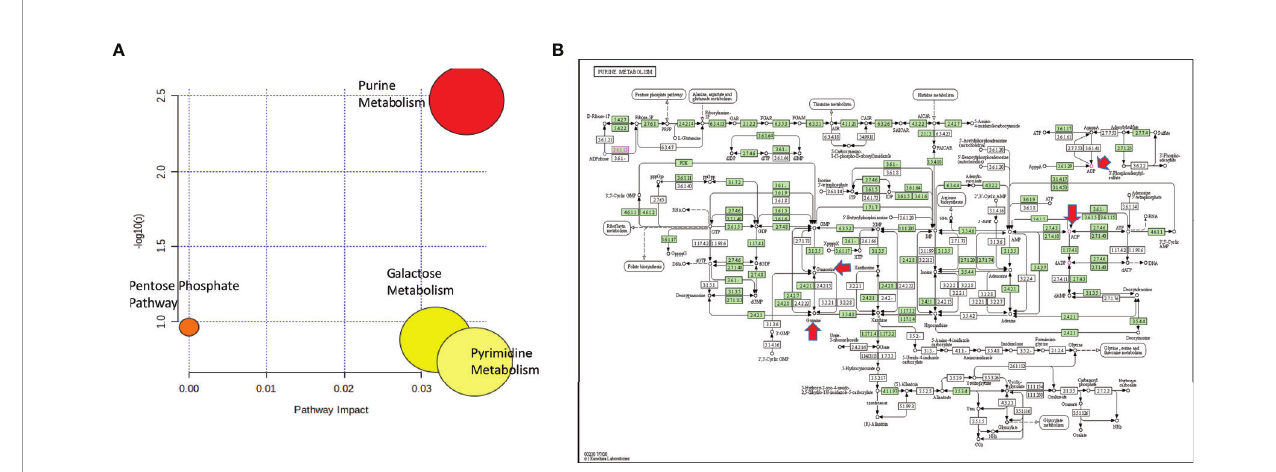
FIGURE 4 | (A) Pathway analysis of metabolites signi fi cantly associated with cytarabine AUC. (B) The lone signi fi cantly associated metabolic pathway was purine metabolism. Guanine, ADP and guanosine are highlighted by red arrows in the KEGG purine metabolism